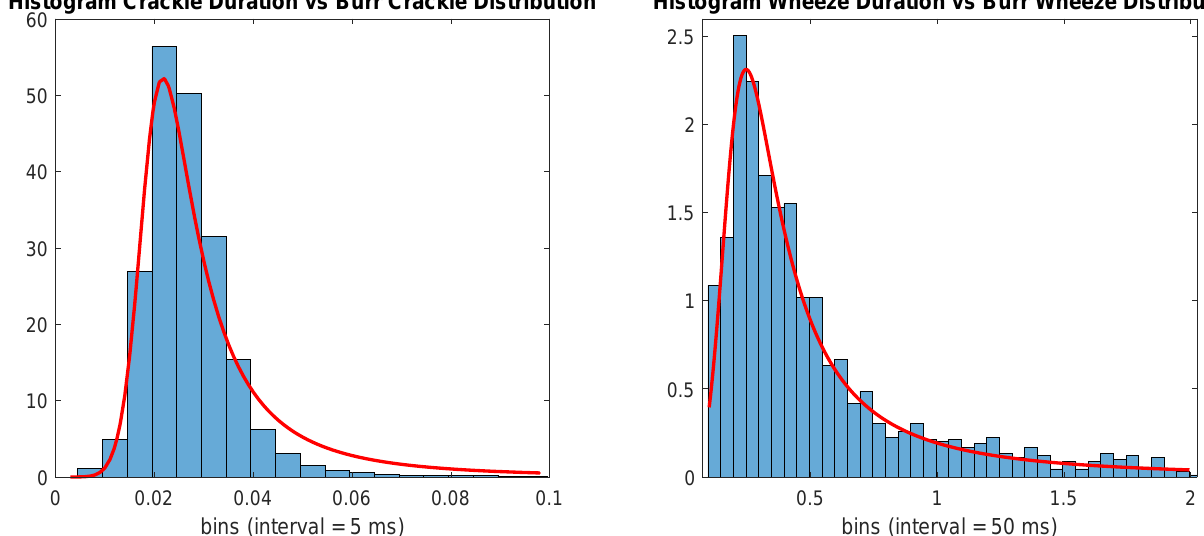
Figure 1. Histogram of adventitious respiratory sounds (ARS) events’ durations versus Burr distributions (red line)